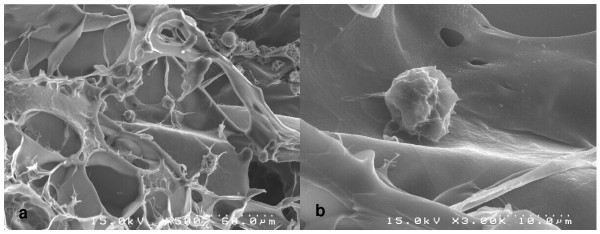
A scanning electron microscopy picture showing the morphological structure of chondrocytes within the cell-fibrin gel. The cell-fibrin gel was incubated in a CO2 incubator and was freeze-dried in order to reveal the scaffold structure. a) ×500, b) ×3000.